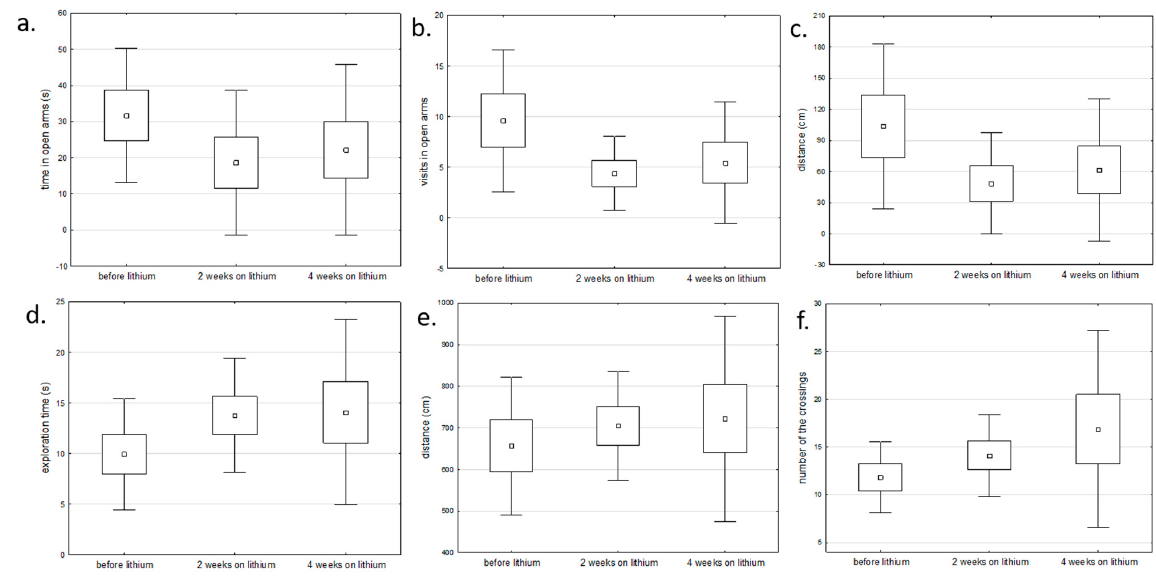
Figure 6. The comparison of behavioral changes before and after lithium administration in: ( a – c ) rats with manic-like behavior using elevated maze test and ( d – f ) rats with depressive-like behavior using open field test (one-way analysis of variance).